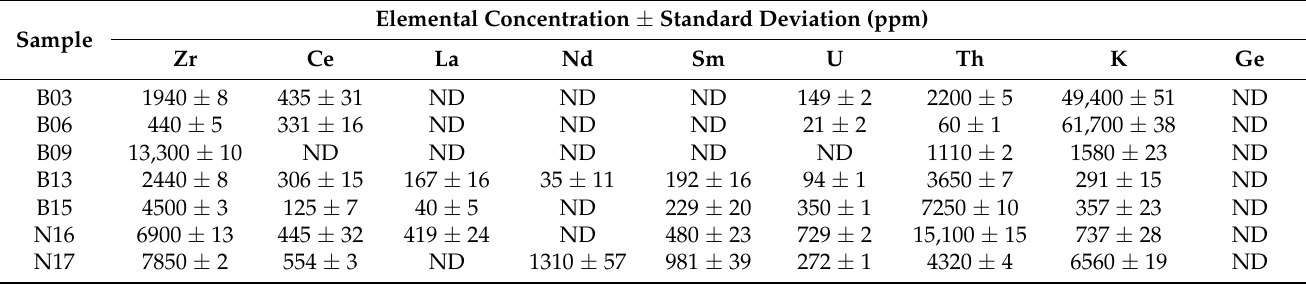
Table 1. Elemental concentrations of the bracelets and necklaces. (Quoted in ppm for the purpose of consistency). Elemental Concentration ± Standard Deviation (ppm) Sample